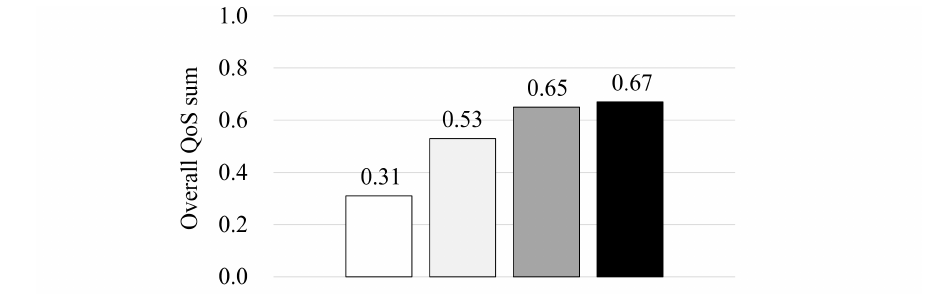
Figure 19. Execution sequence of 9 test applications.